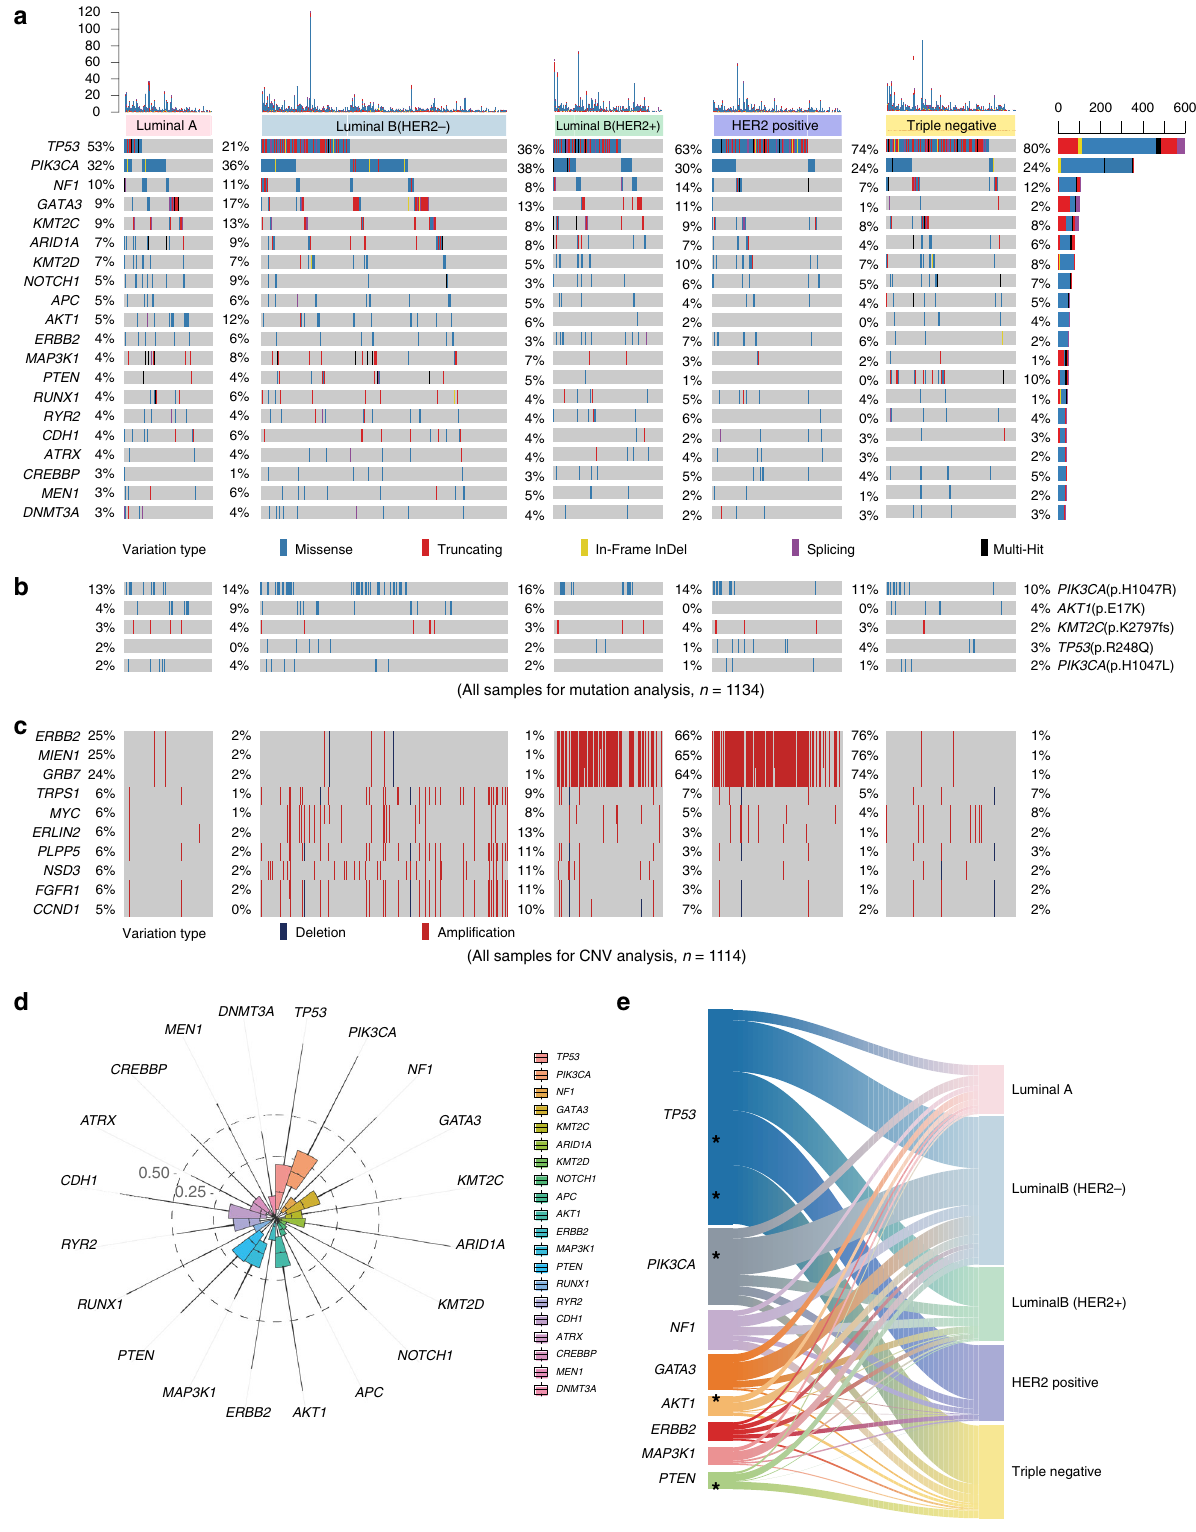
Fig. 2 Genomic landscape and characteristics of prospectively sequenced Chinese breast cancer. a Sequencing data of 1134 Chinese breast cancer samples classi fi ed by the molecular subtype and mutation pro fi le and annotated with the variation type and mutation frequency. The mutation counts in each sample and each gene are provided above and on the right side, respectively. b Hotspot mutations (frequency higher than 2%) in Chinese breast cancer. c Copy number variations (CNVs) of 1114 Chinese breast cancer samples classi fi ed by the molecular subtype in our cohort. d Distribution of variant allele fractions (VAFs) in the recurrently mutated genes. e Recurrent genomic mutations (left and right) and their association with different molecular subtypes (middle). The asterisks indicate a statistically signi fi cant association with the subtype (FDR <